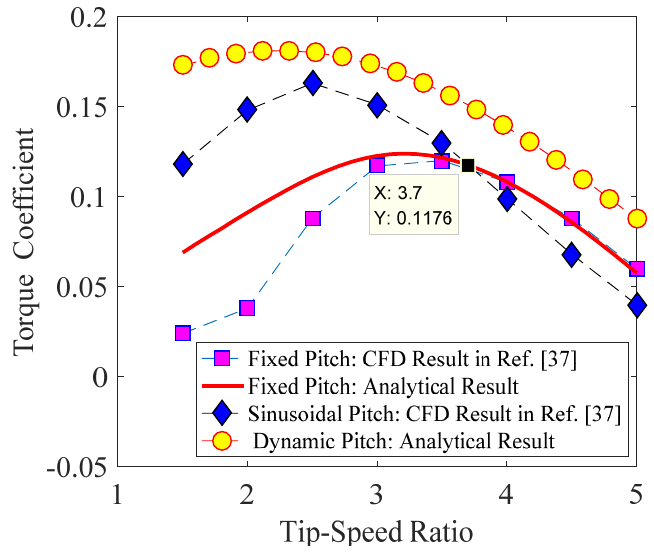
Figure 26. Comparison of the current optimization with CFD results in [37].